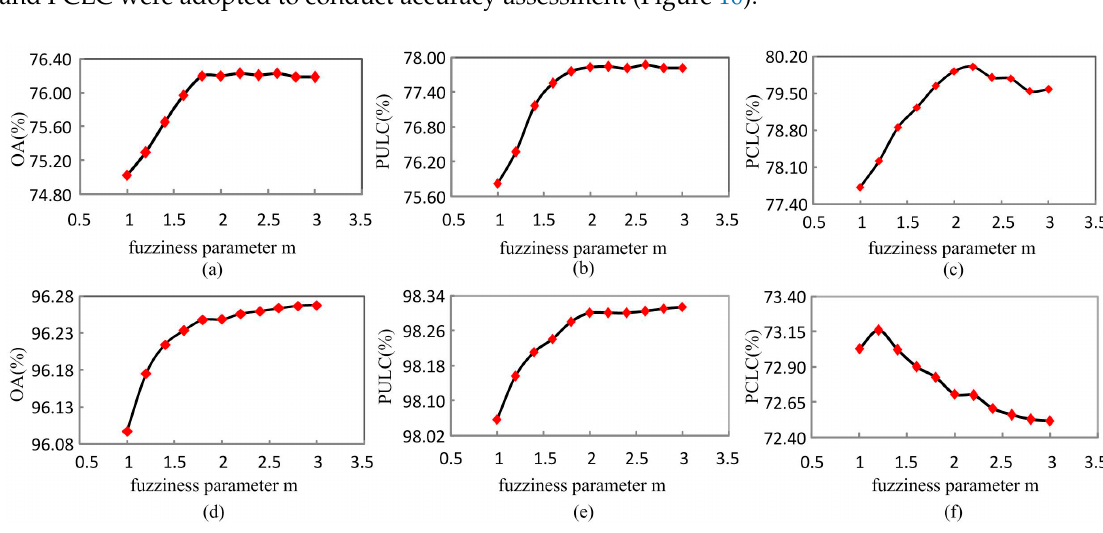
Figure 10. Accuracy assessment of FCM_SRM and FCM_STSRM with different fuzziness parameters: